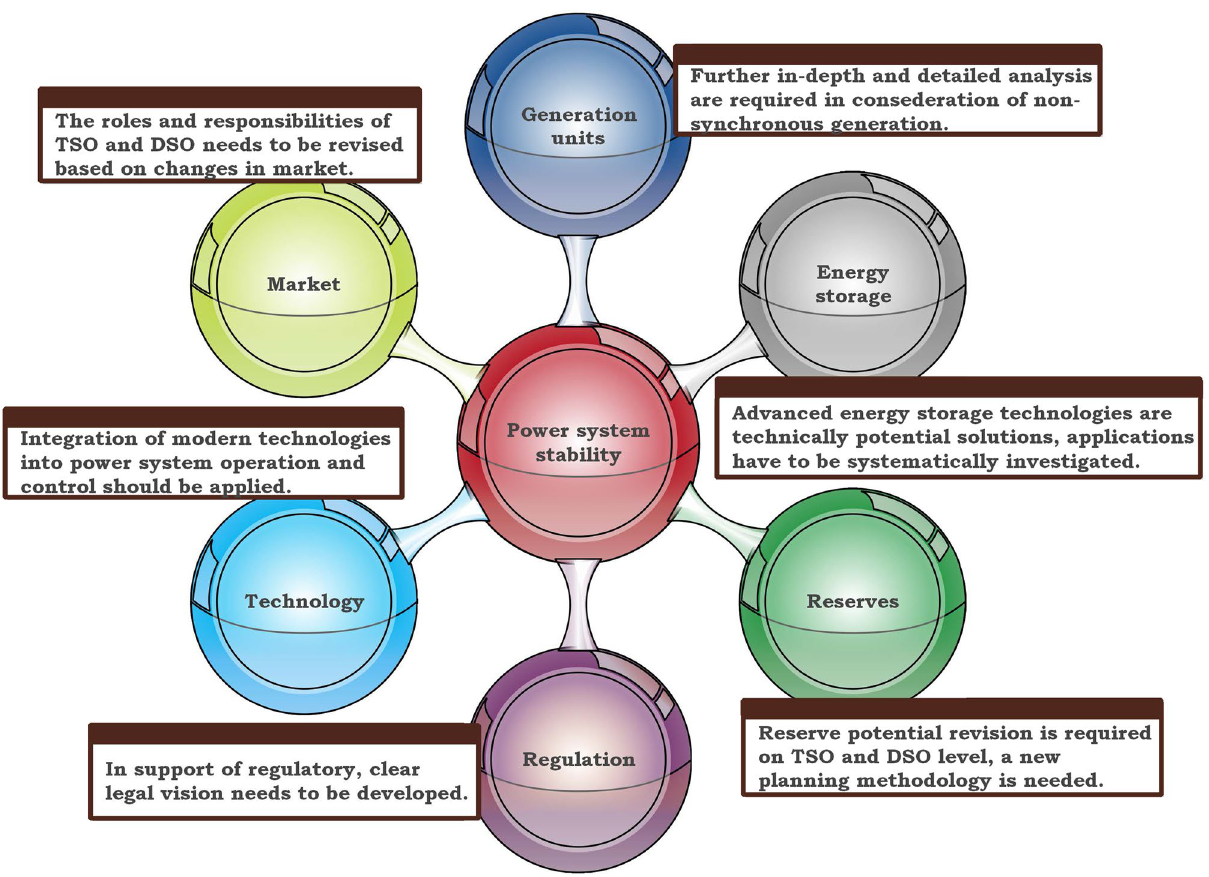
Figure 8. Various aspects regarding power system stability in non-synchronous generator